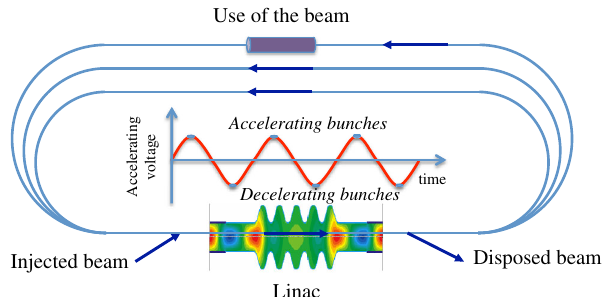
FIG. 1. A simplified sketch of a three-pass ERL comprised of the linear accelerator and three